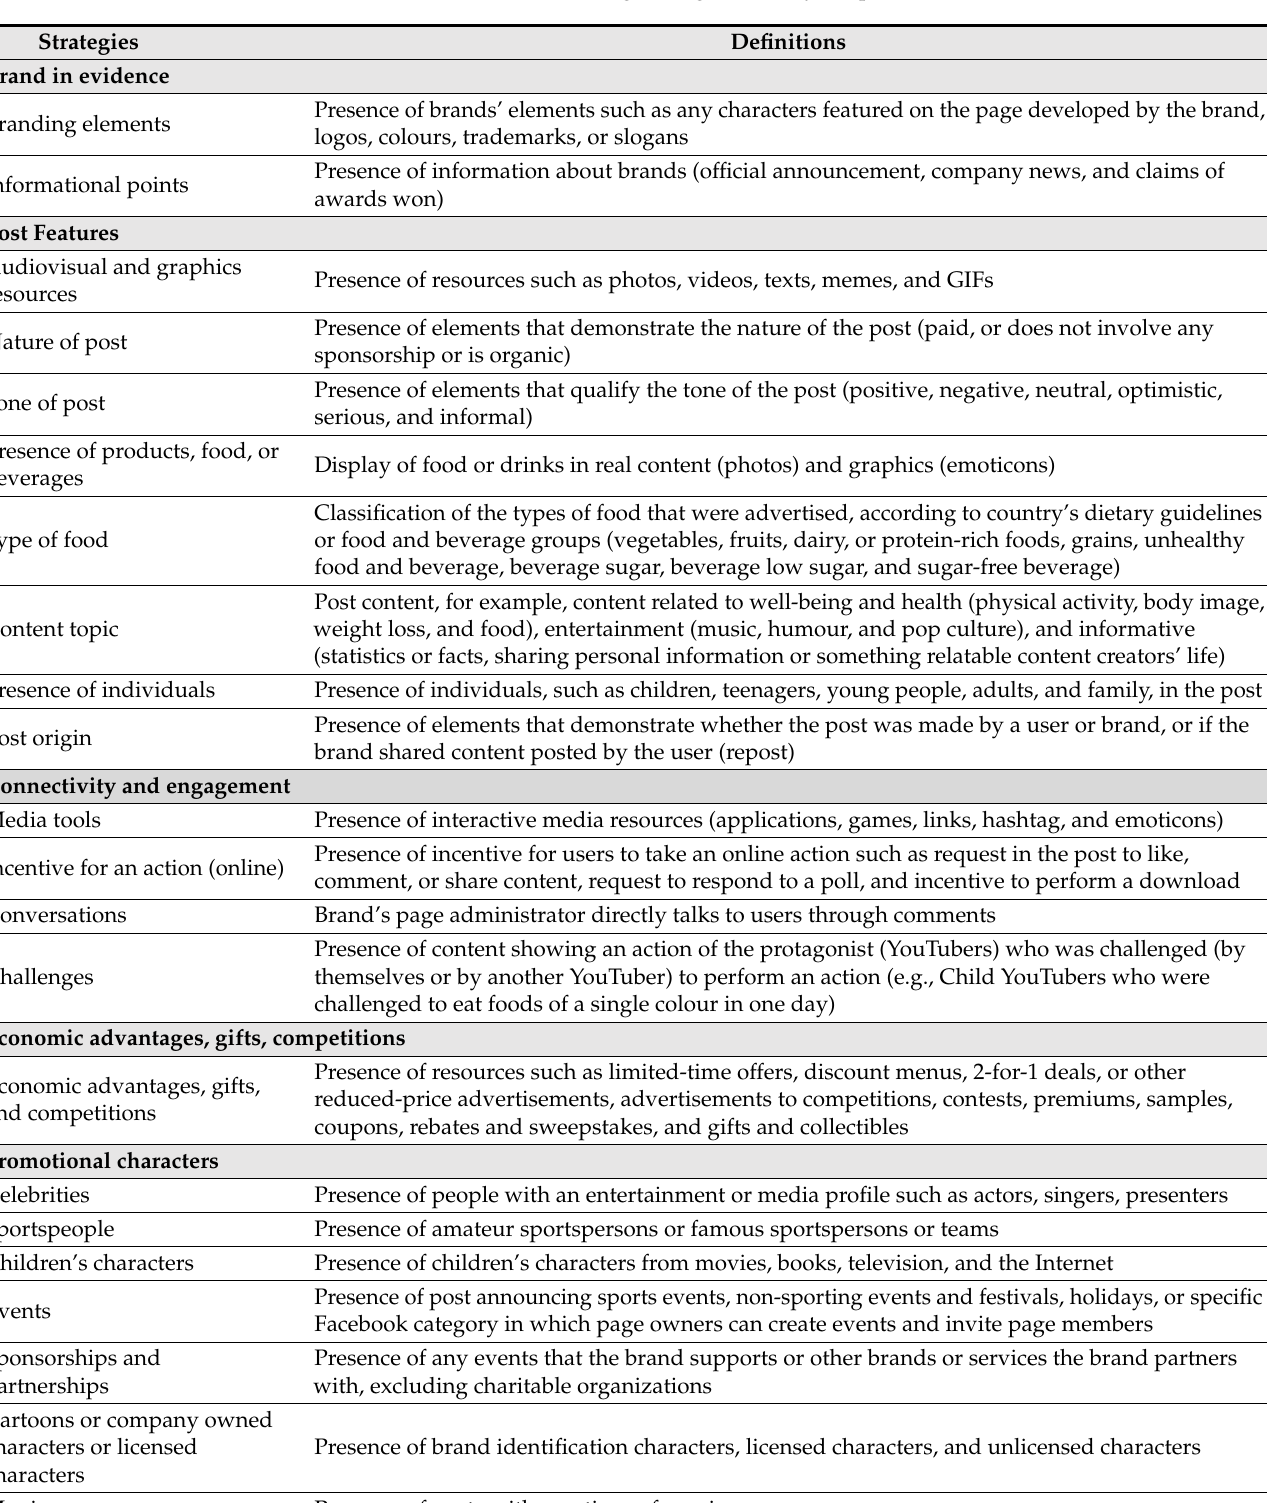
Table 3. Definitions of advertising strategies used by the publications included in the